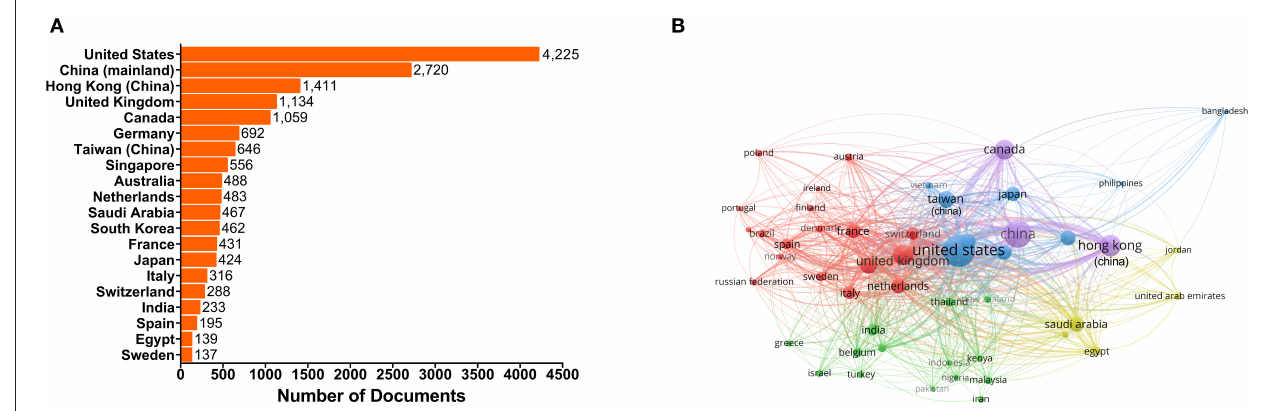
FIGURE 2 | Top 20 countries or territories with the most documents and country or territory co-authorship analysis map. (A) Top 20 countries or territories with the most publications. The bars show the number of documents produced by the country or territory. (B) Country or territory co-authorship analysis map. The size of each node indicates the number of documents produced by the country or territory. The thickness of each link indicates the strength of collaboration relationship between two countries or territories. The distance between two nodes indicates the relatedness of the links they each has. Nodes with some common attributes are assigned to a cluster and are